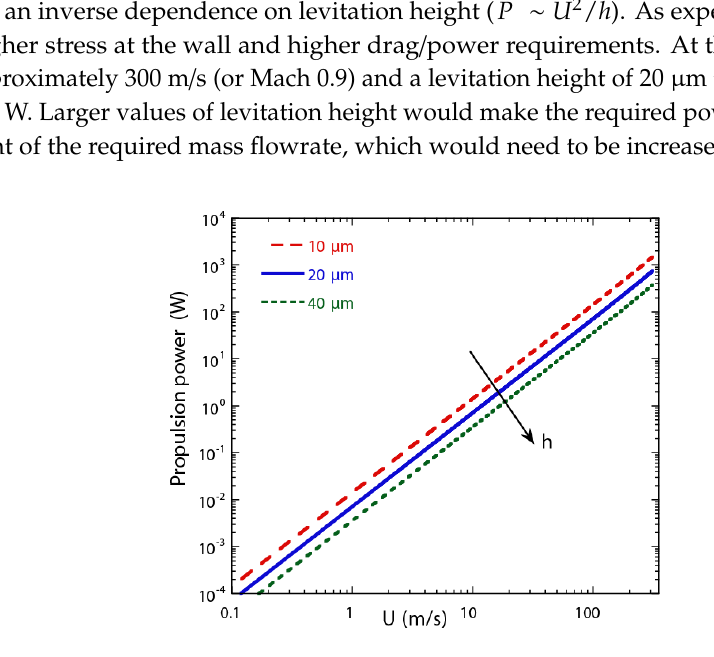
Figure 5. Mass flowrate requirement and available levitation time for a 2200-N Hyperloop pod.